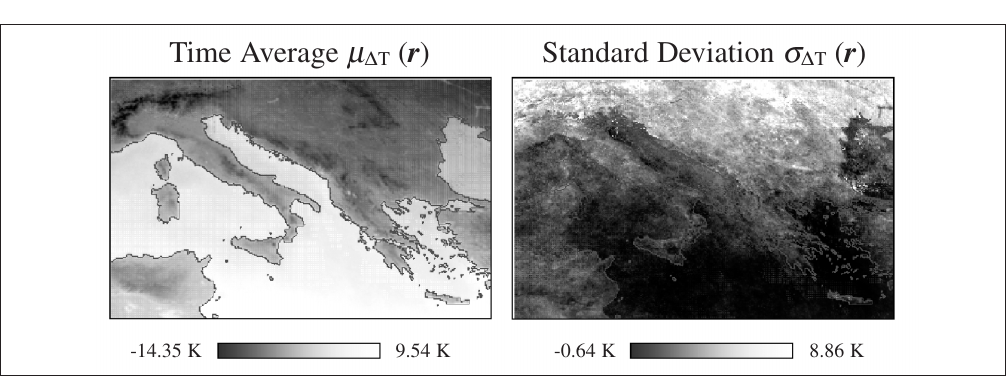
Fig. 1. Reference field (time average µ ∆ T and standard deviation σ ∆ T ) on the study area for the month of Oc- tober at 24:00 GMT computed on Meteosat TIR records over the years 1992-2000 (see